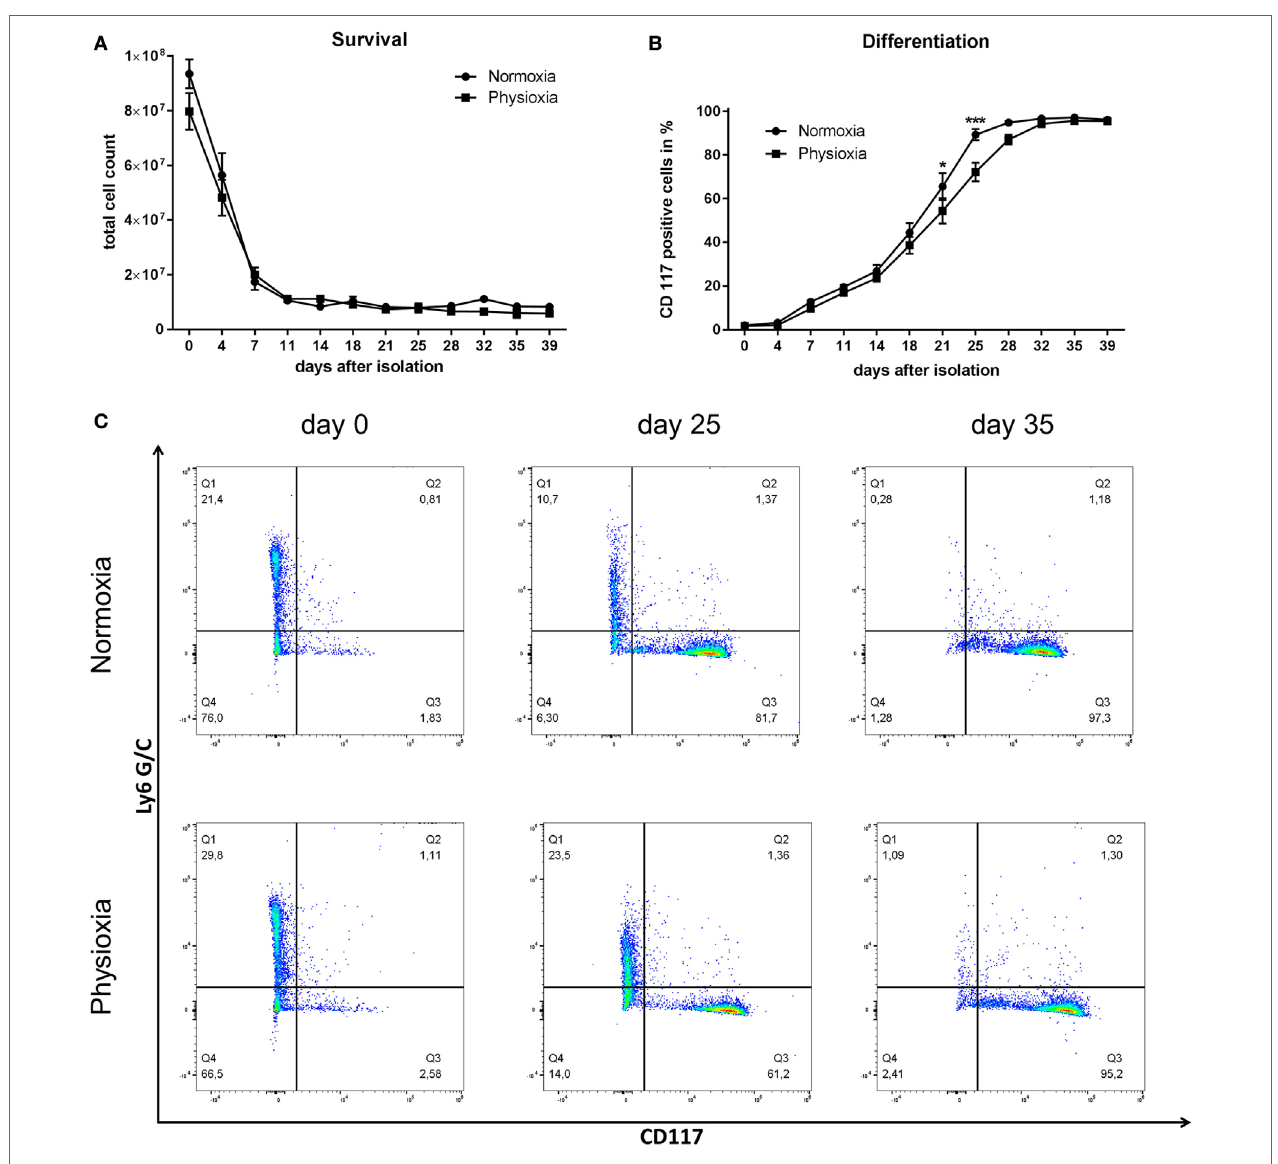
FiGUre 2 | (a) Total cell count of viable cells was determined by counting with a Neubauer counting chamber using trypan blue discrimination. No significant differences in cell survival and cell number are observable under physioxia compared to normoxia. The initial loss of cells in the first week of cultivation is due to strong selection of the primarily very diverse bone marrow-derived cell population. Depicted are mean values and SEM from cell suspensions of n = 3 separated BMMC-batches derived from three mice (not pooled). (B) Time-dependent CD117 expression as marker for mast cell (MC) differentiation. Increasing CD117 expression over time indicates progressing MC differentiation that is slightly but significantly delayed under physioxic culture conditions compared to normoxia at day 21 and 25 post-isolation. Depicted are mean values and SEM from cell suspensions of n = 3 separated BMMC-batches derived from three mice (not pooled). (C) Representative dot blot diagrams of Ly6 G/C- and CD117-labeled cells on day 0, 25, and 35 post-isolation, cultivated under normoxia or physioxia. Cells were stained for the surface markers Ly6 G/C and CD117. Q1: Ly6 G/C positive cells, Q2: double positive cells, Q3: CD117 positive cells, Q4: double negative cells. Independent of the oxygen level, the number of Ly6 G/C-positive cells decreases while the amount of CD117-positive cells increases during cultivation.